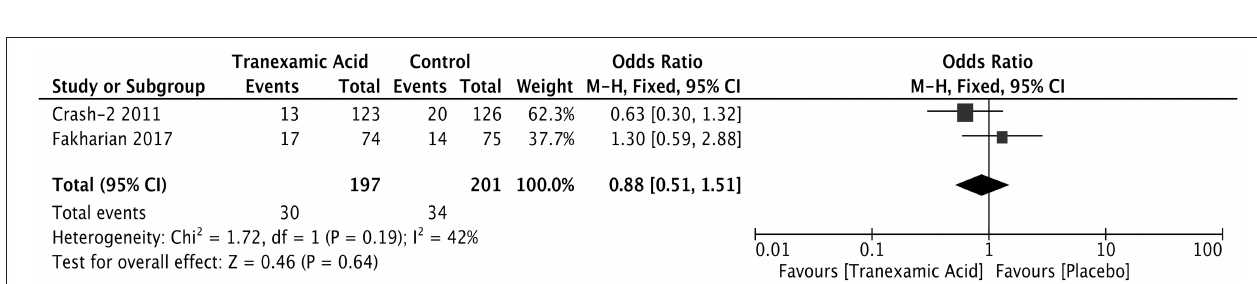
FIGURE 6 | Forest plot of the comparison between tranexamic acid and placebo treatments for neurosurgical intervention.